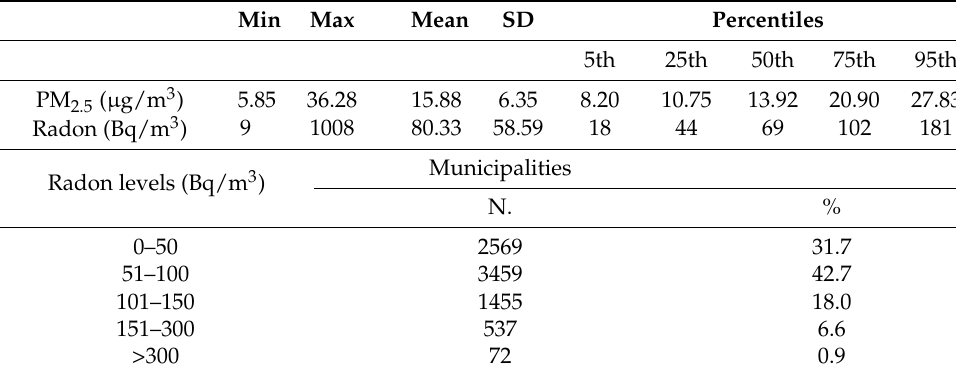
Table 2. Environmental variables: exploratory statistics, 2006–2015